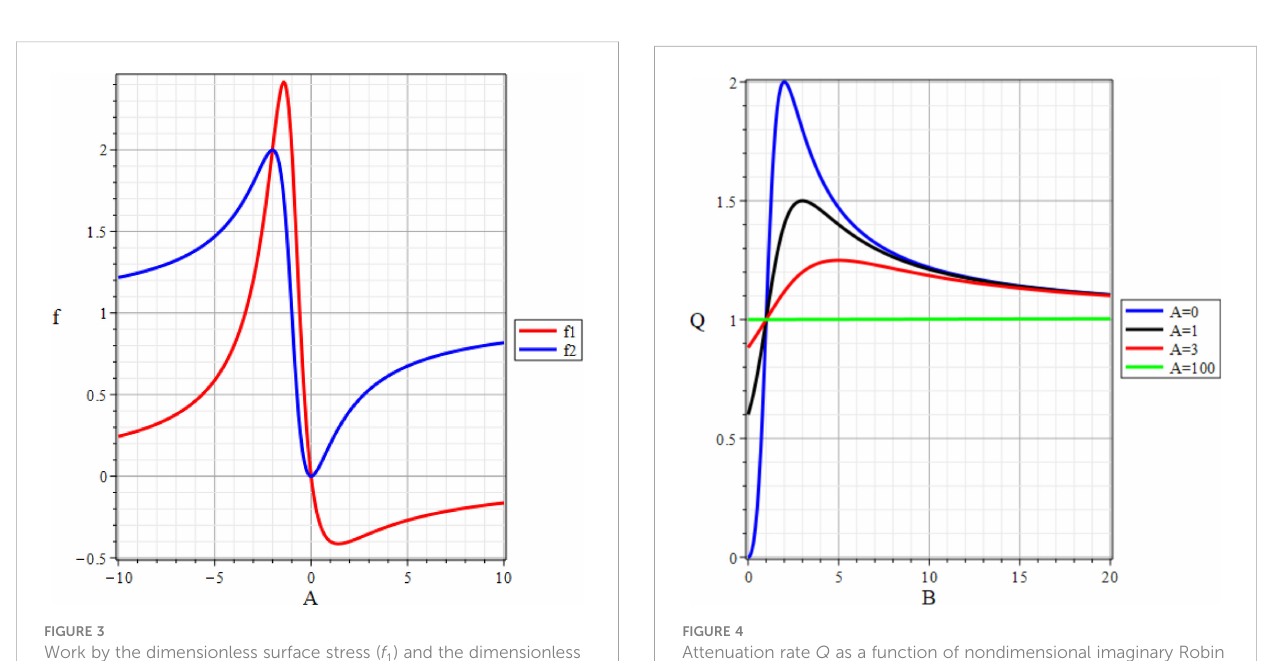
FIGURE 3 Work by the dimensionless surface stress ( f 1 ) and the dimensionless dissipation ( f 2 ) as functions of the nondimensional real Robin parameter A = R r = g .